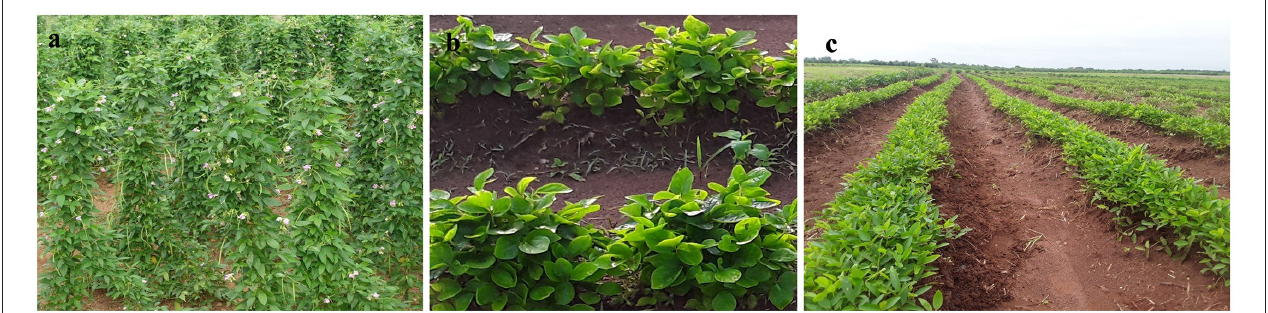
FIGURE 1 | Field images of African orphan legumes (a) African yambean, (b) Kersting’s groundnut, (c) Bambara